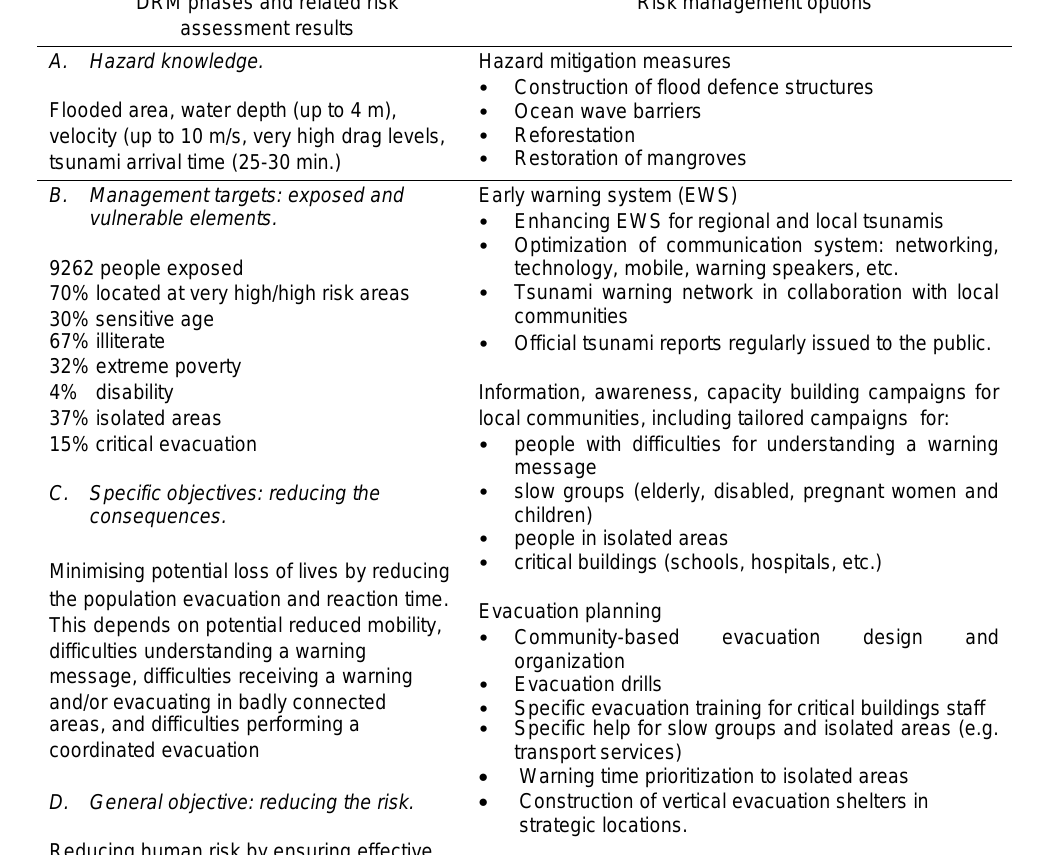
Table 4. Translation of human risk results into DRM options (Acajutla, Western Coastal Plain, El Salvador). Further information provided by González-Riancho et al. (2013).